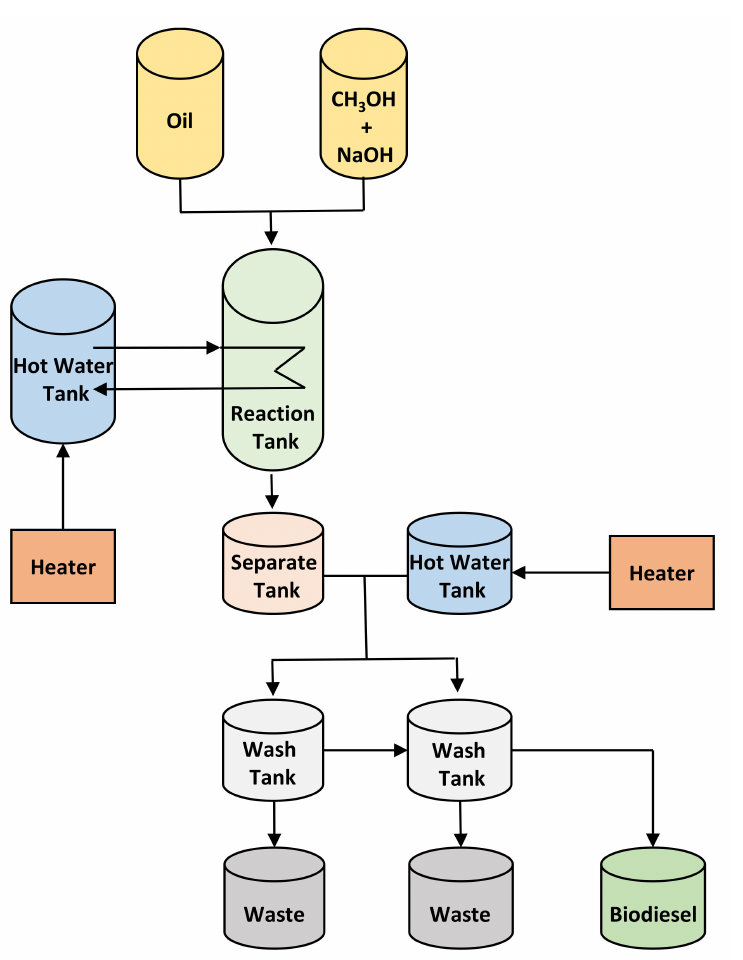
Figure 21. Diagram of biodiesel production process.